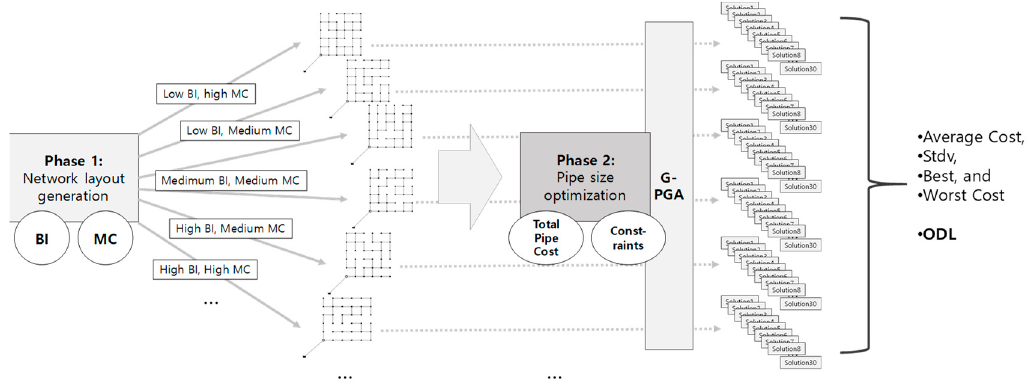
Figure 1. Schematic of the proposed two-phase optimization difficulty level (ODL) examination framework.